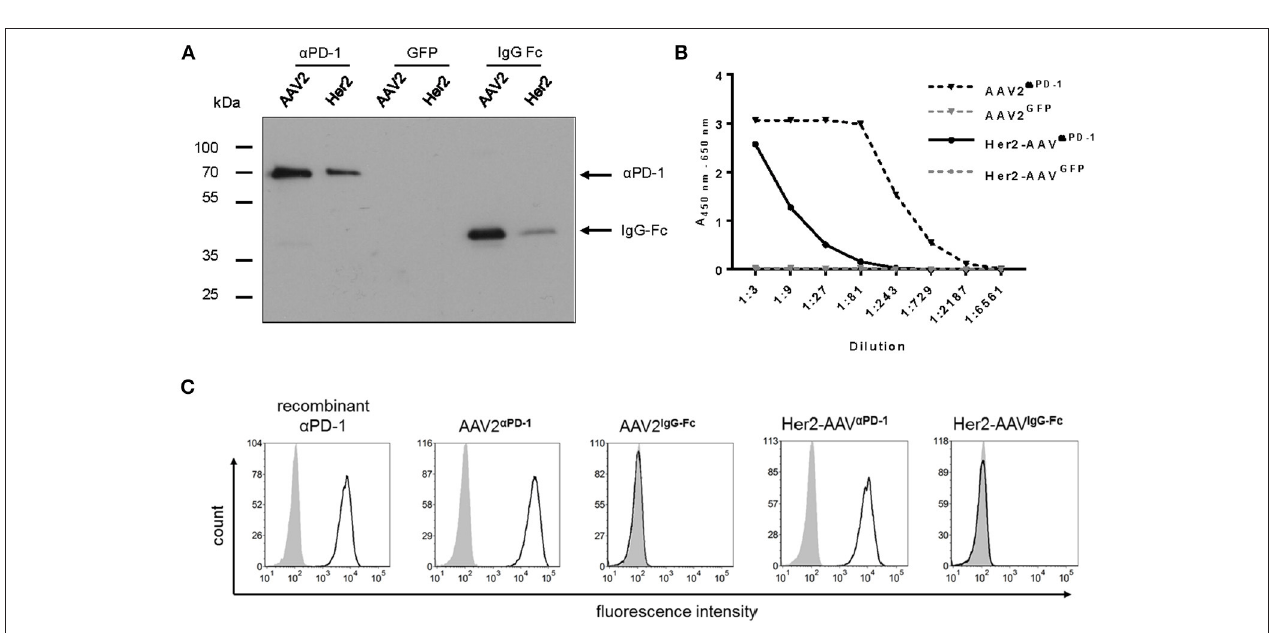
FIGURE 2 | Characterization of AAV-encoded α PD-1. Four days after incubation of RENCA-Her2/neu cells with AAV2 or Her2-AAV vectors encoding α PD-1, IgG-Fc or GFP (450,000 genome copies/cell), cell culture supernatants were collected and transgene expression was analyzed. (A) Western blot analysis using an HA-specific antibody. (B) Sandwich ELISA with IgG-Fc- and HA-specific antibodies. (C) Specific antigen recognition of AAV encoded α PD-1 from cell culture supernatants of vector transduced cells and recombinant α PD-1 were assessed on PD-1 negative (gray shaded profiles) and PD-1 positive HT1080 cells (empty profiles, black line) by flow cytometry. The binding of α PD-1 was detected via an IgG-Fc-specific antibody. As further control, PD-1 positive and parental HT1080 cells were incubated with supernatant of AAV2 IgG − Fc transduced cells.